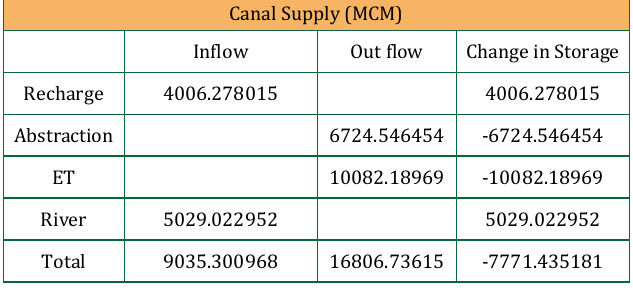
Table 6: Annual GW abstraction increased 30% with same Canal